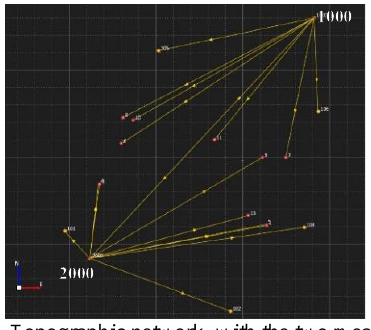
Figure 4. Topographic network, with the two measurement stations 1000 and 2000, and the measured targets.